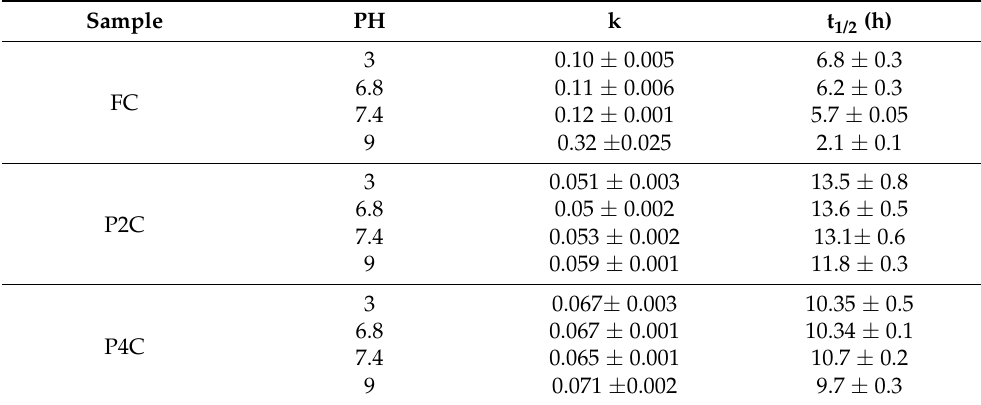
Table 1. The degradation rate constant and t 1/2 at degradation for FC and curcumin encapsulated in P2C and P4C ComPs in different pH